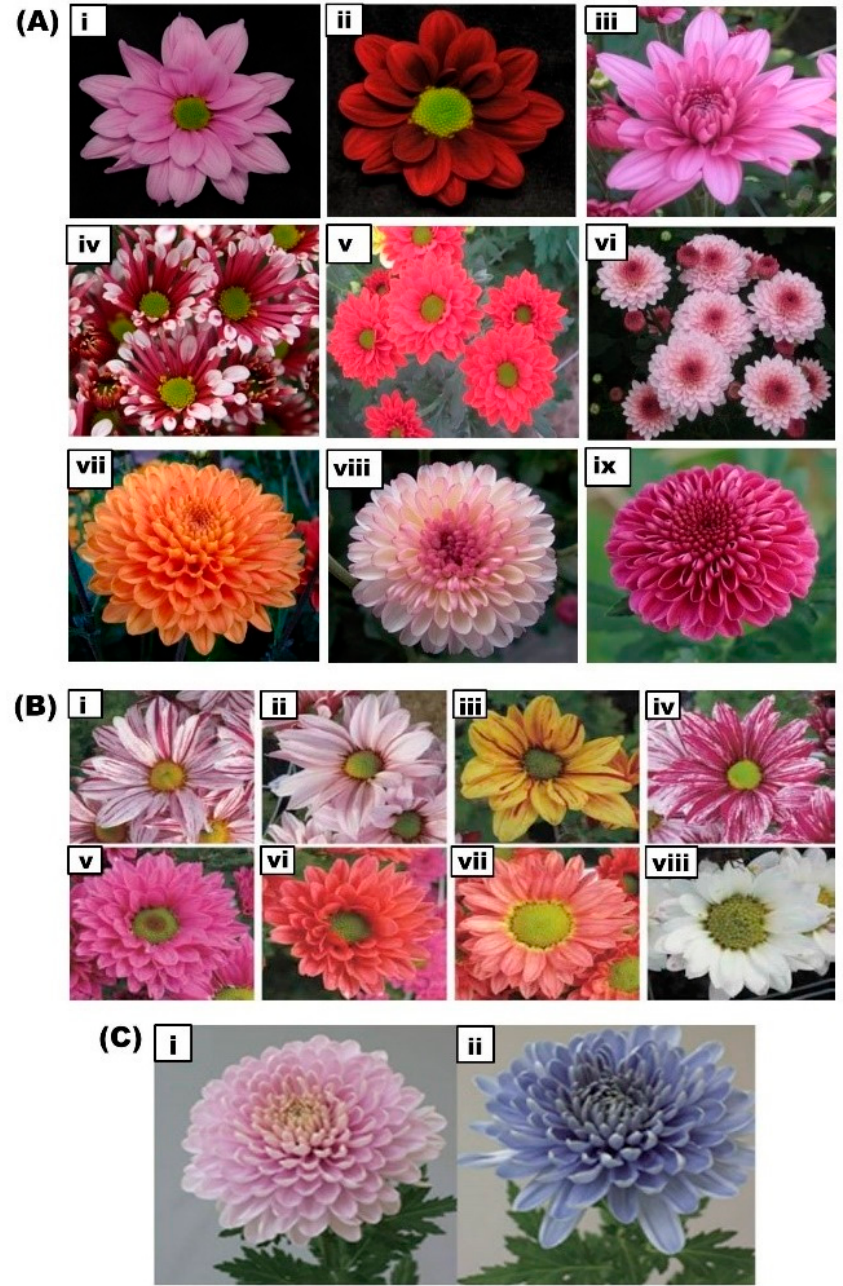
Figure 3. Representative images showing the modification of floral color in chrysanthemum by various breeding methods. ( A ) Diverse and vibrant colored flowers expressing anthocyanins in chrysanthemum cultivars developed by our work through cross breeding at (National Institute of Horticultural and Herbal Sciences (NIHHS), RDA, Korea. ( i ): Glory pink; ( ii ): Red marble; ( iii ): Donna pink; ( iv ): Purple cone; ( v ): Princeling; ( vi ): Cutie pink; ( vii ): Orange pangpang; ( viii ): Pink pangpang: and ( ix ): Purple pangpang. ( B ) Modification of floral color by mutation breeding. A range of floral colored mutants presenting various colors were generated by gamma-irradiation in two chrysanthemum cultivars ‘Noble wine’ and ‘Pinky’. ( i ): Original floral color of ‘Noble wine’; ( ii – iv ): gamma-irradiated mutants of ‘Noble wine’ showing varied floral colors. ( v ): Original floral color of ‘Pinky’; and ( vi – viii ): gamma-irradiated mutant floral colors of ‘Pinky’ [107]. ( C ) Generation of blue-colored chrysanthemum flowers by metabolic engineering. ( i ): wild-type red-purple colored flower; ( ii ): transgenic blue-colored flower generated in combination with the overexpression of CamF3’5’H and CtUGT, and co-pigmentation [40].